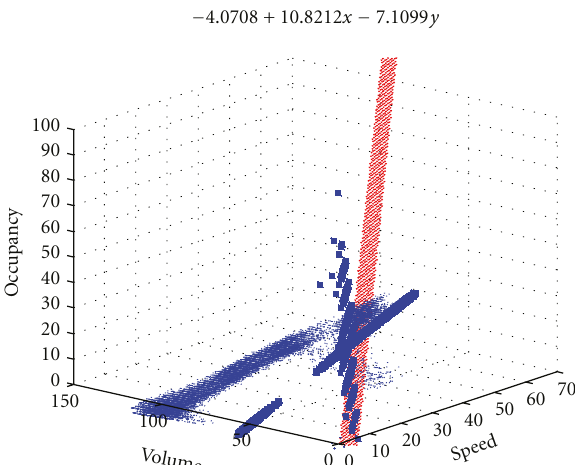
Figure 12: Dense Tra ffi c Plane for D-SVM of OAAM.